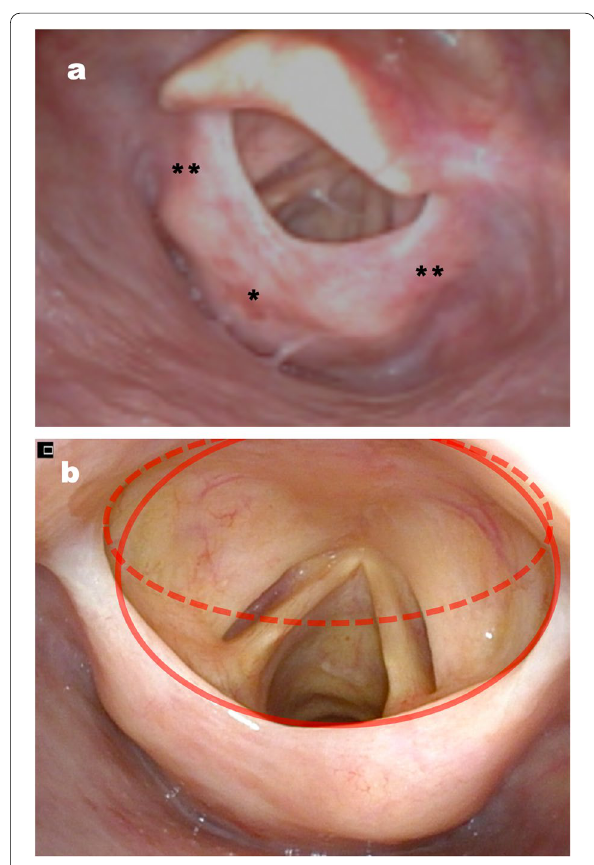
Fig. 1 Preoperative flexible fiberscope image. a The wide angle of glottis view by preoperative flexible fiberscope. Radiotherapy for hypopharyngeal cancer elicited a cicatricial change in the arytenoid region * to bilateral aryepiglottic fold ** over a long period of time. Even cylindrical cicatricial change above vocal cord was observed, we could not evaluate this change at the physical examination 1 day before surgery. b The close angle of glottis view by preoperative flexible fiberscope. The change of shape in supraglottic hyperplasic cicatricial tissue during video laryngoscope exposer. As we inserted McGRATH ® and tried to visualize the vocal cord, the red line changed to the red dotted line when we pulled the epiglottis